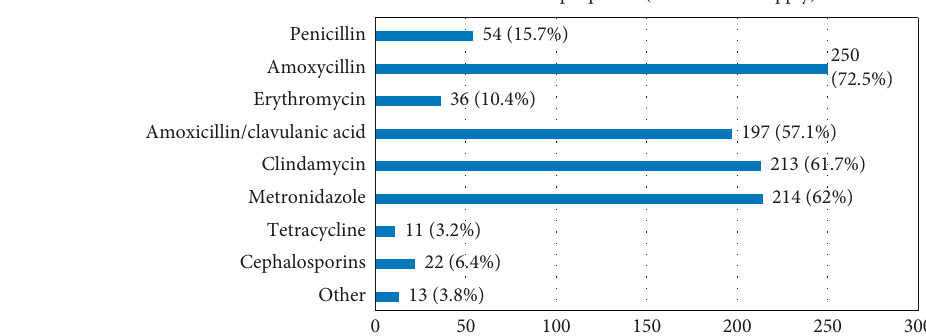
Figure 3: Antibiotics prescribed by dentists for treatment